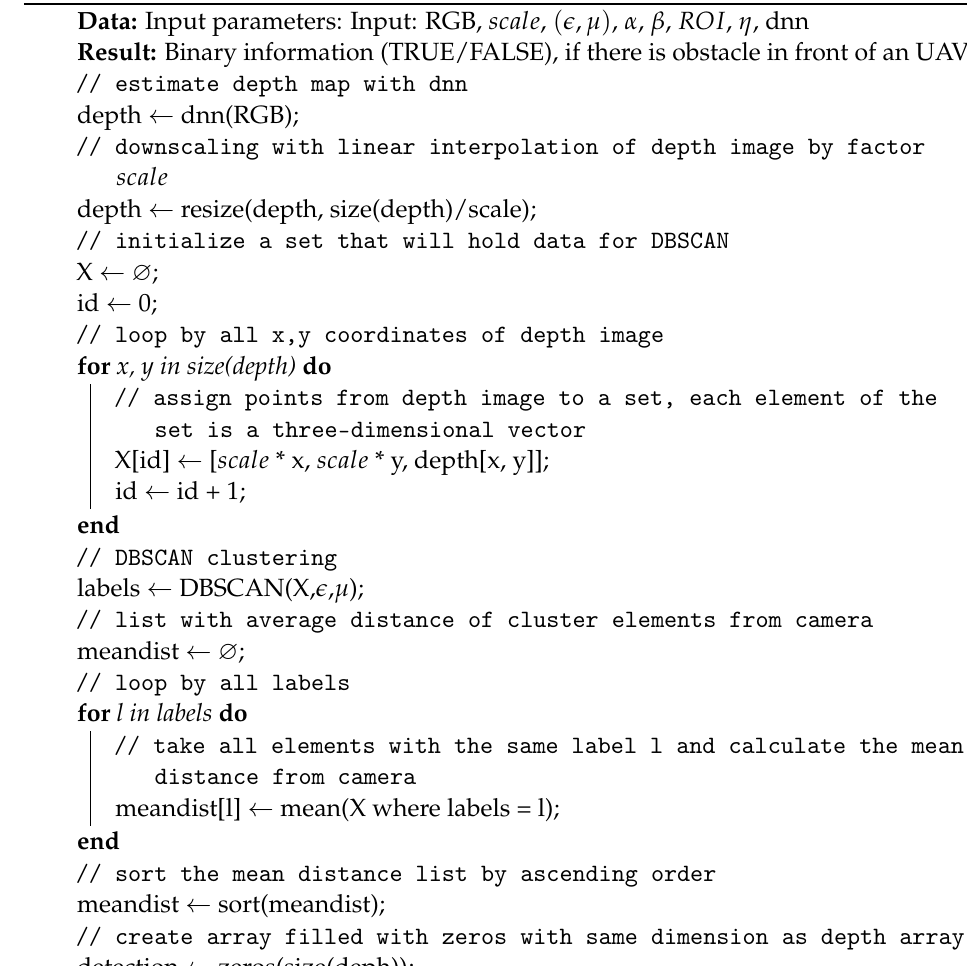
Algorithm 1: Algorithm of potential obstacle detection from RGB